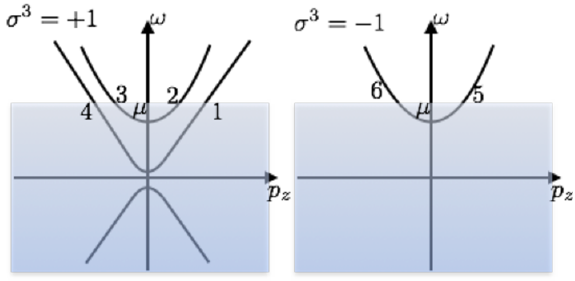
Figure 5 . The de(cid:12)nition of the labels for the states on the Fermi energy. We keep the same notation even for strong magnetic (cid:12)eld case 2 eB > (cid:22) 2 (cid:0) m 2 , in which only the states 1 and 4 exist.